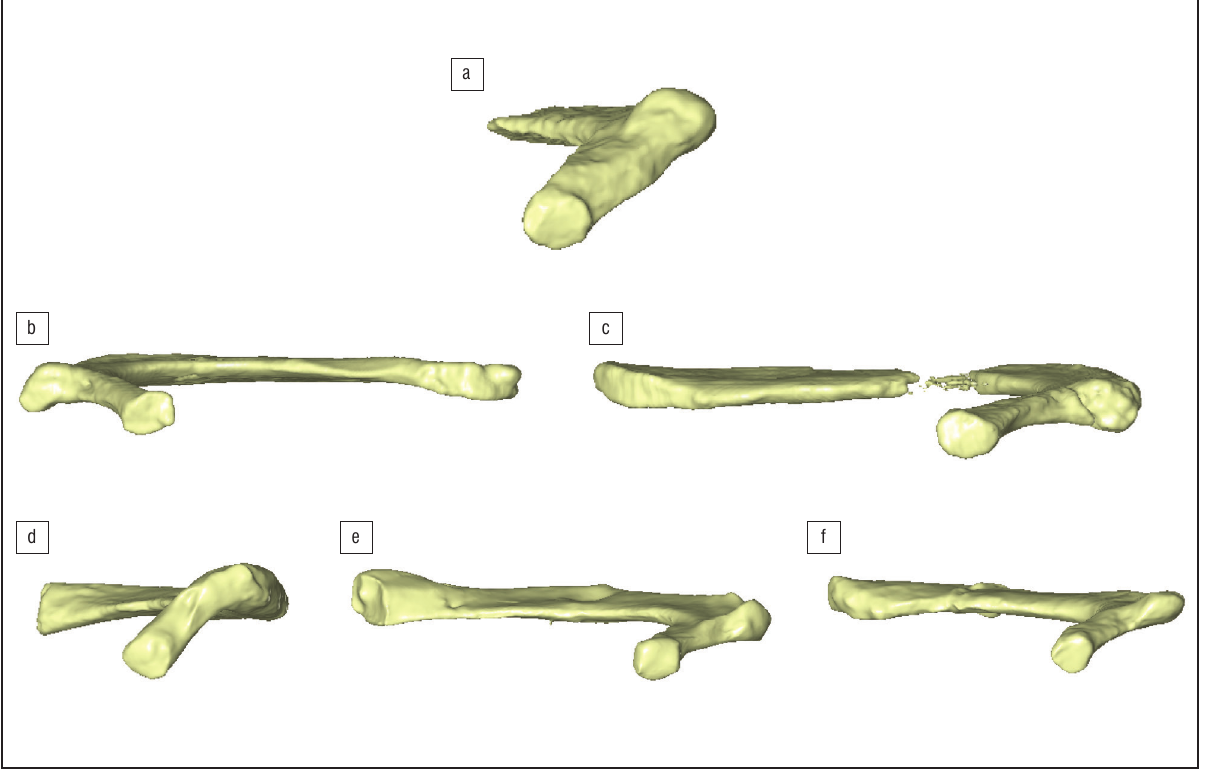
Figure 4: Detail of the single articular facet at the rib head of every fossil specimen studied in the sample: (a) StW 670, (b) KNM-WT 15000 left, (c) KNM- WT 15000 right, (d) AL 288-1, (e) MH1 and (f) MH2. As the goal of this image is to display the single facets, every specimen has been scaled to the same